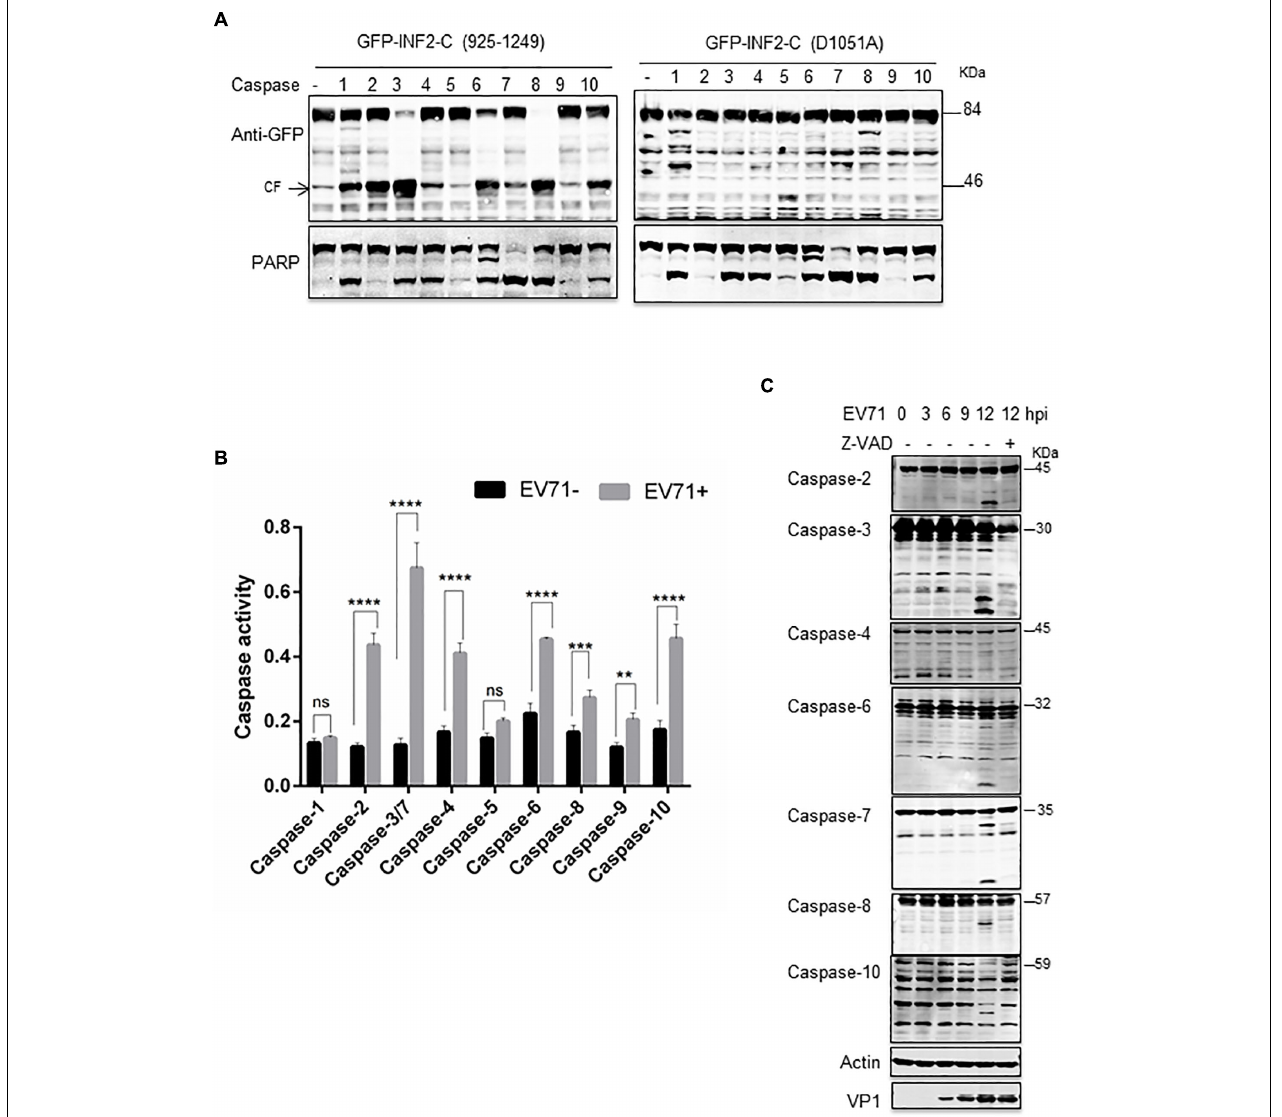
FIGURE 5 | Multiple caspases are activated in EV71-infected cells. (A) in vitro caspases cleavage assay. RD cells were transfected with plasmids encoding GFP-INF2-C (925–1,249) or GFP-INF2-C (D1051A). Twenty-four h after transfection, the cells were lysed. The cell lysate was incubated with the indicated activated caspases for in vitro cleavage assay; then, a Western blot was conducted with the indicated antibody. PARP was used as an indicator of most caspases’ activation, and arrows indicate the cleavage fragments (CF). (B) RD cells were infected with EV71 (MOI = 10) for the indicated times, untreated (–) or treated (+) with 100 µ M Z-VAD, for 6 h. The cells were harvested, and Western blot was performed using the indicated antibodies against different caspases, actin, and VP1. (C) Colorimetric caspase activity assay in mock-infected (EV71-) and EV71 infected RD cells. RD cells were infected with EV71 (MOI = 10) for 12 h, the cells were then harvested, and cell lysis was incubated with caspase colorimetric substrate to determine the caspase activity. Results are presented as mean ± SD of three replicates. Statistical significance was determined by the two-way ANOVA multiple comparisons test. ns, not significant. ** P < 0.01; *** P < 0.001; **** P <